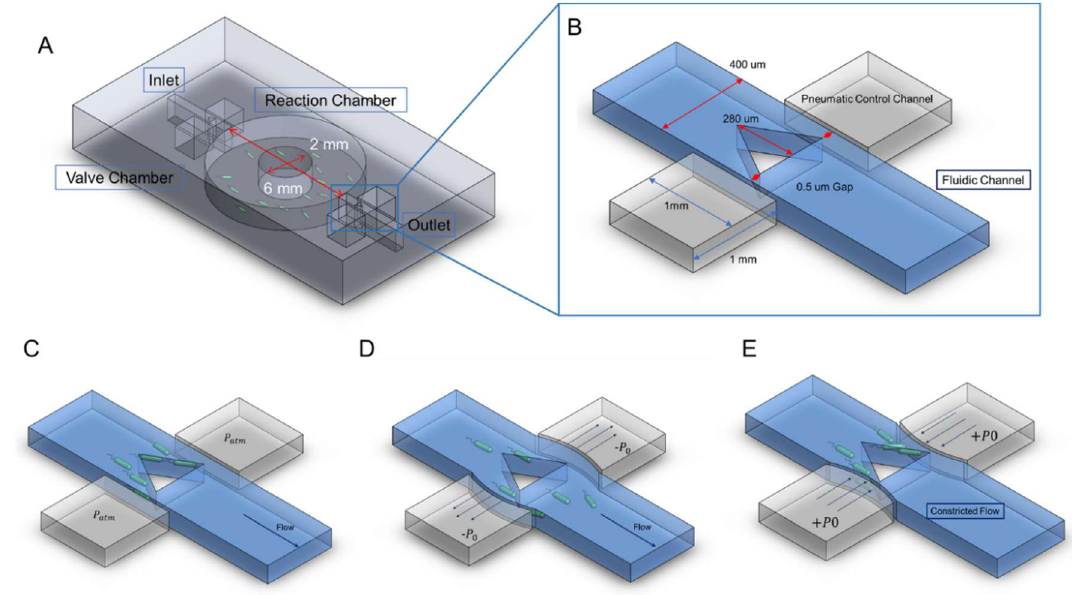
Figure 1. Schematic of the microfluidic device and working principle of the semi-always-closed valve. ( A ) The microfluidic device consists of a large central chamber, a fluidic channel and several pneumatic control channels. ( B ) Close up of the single layer semi-always closed valve. ( C ) In an unaltered state, the opening to the sides of the microfluidic structural element will allow the medium to pass while blocking the pass of bacteria. ( D ) When we subject the pneumatic control channels to negative pressure, the membrane deforms allowing the bacteria to pass freely. ( E ) When we subject the control channels to positive pressure, the membrane will deform cutting off the flow of the medium.